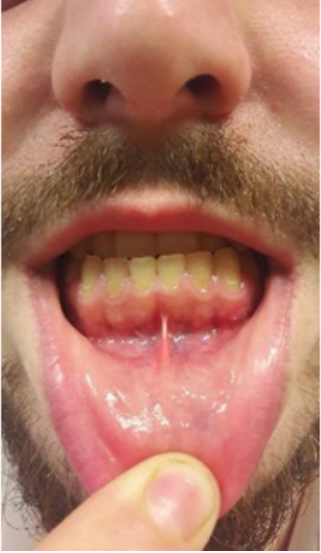
Figure 24. Physical positioning for taking a dental selfie: without a mouth opener